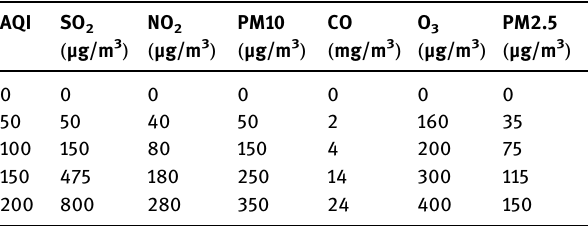
Table A1: Individual air quality index and corresponding pollutants